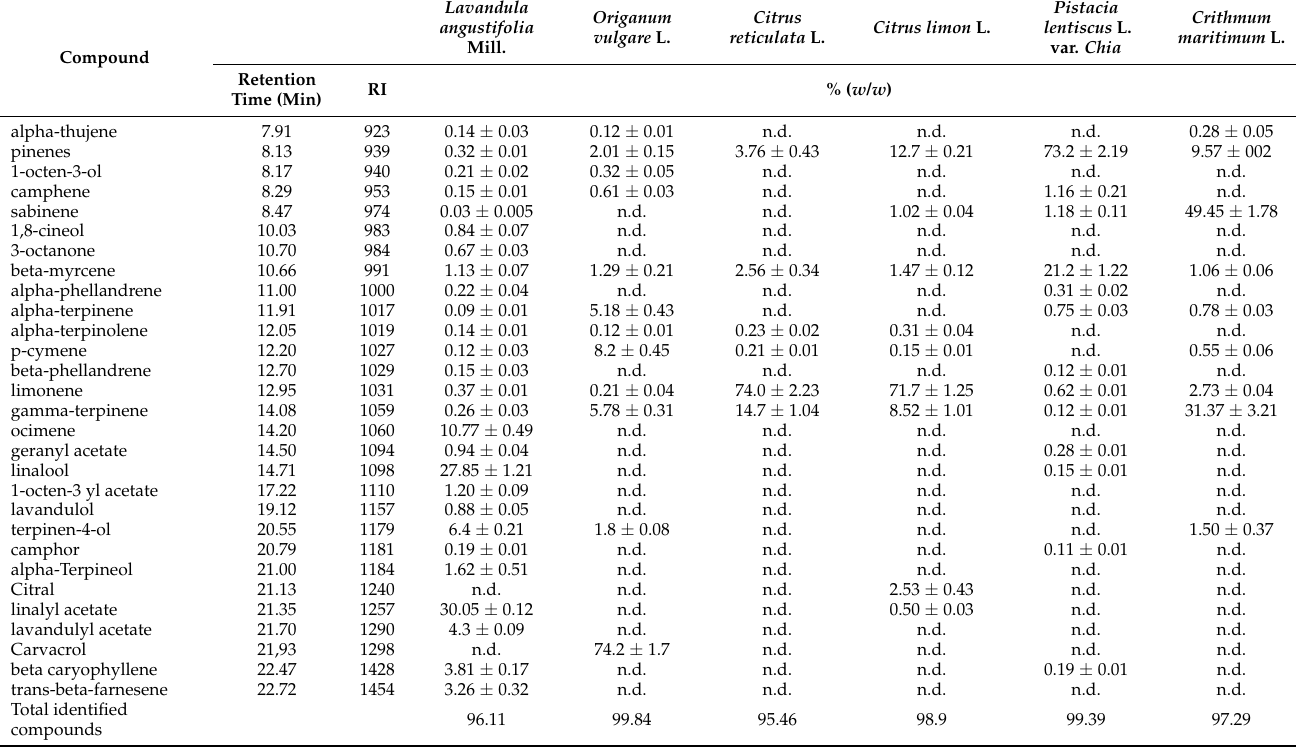
Table 1. Chemical composition of six essential oils analyzed by